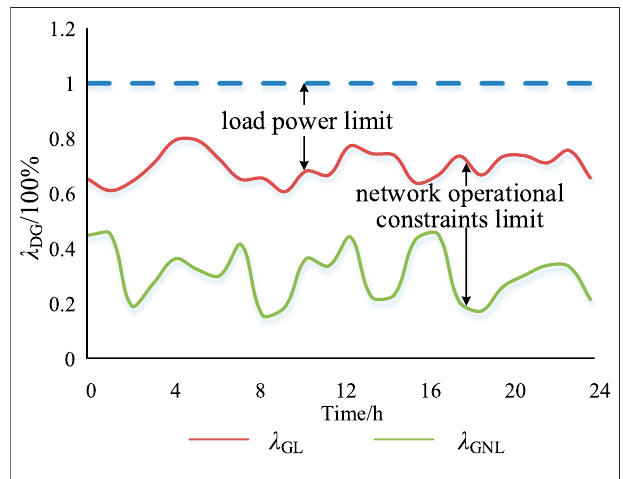
FIGURE 1 | In fl uences on DG accommodation of load power and network operational